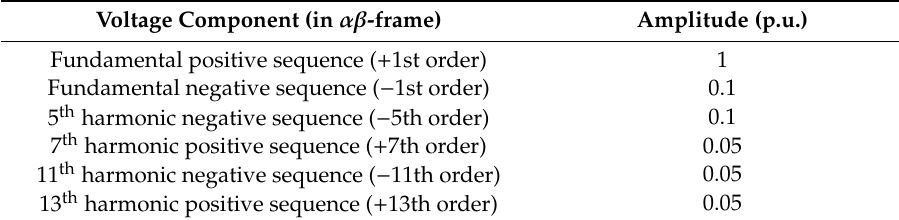
Table 2. Parameters of grid voltages.